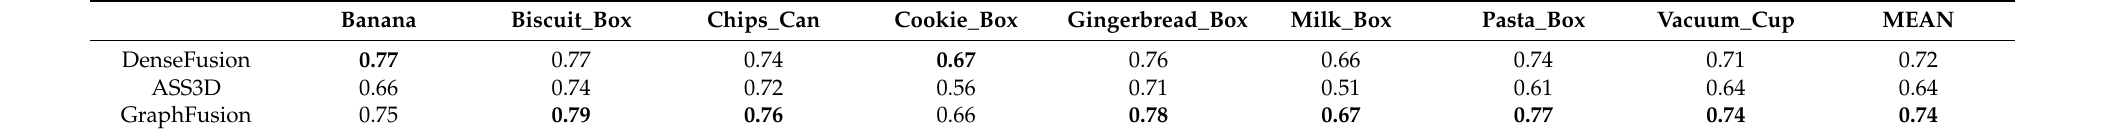
Table 6. The 6D pose estimation accuracy in terms of the area under ADD curve (AUC).